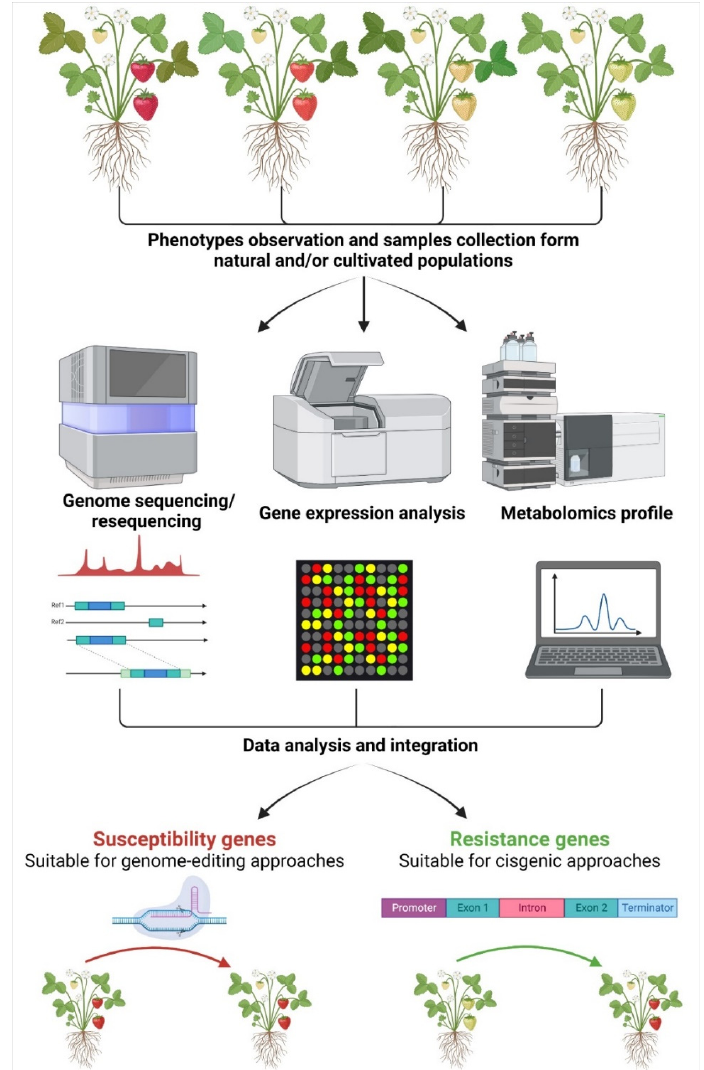
Figure 1. Overview of the multidisciplinary approaches to identify candidate gene(s) exploitable for genome editing or cisgenesis approaches. Starting from the natural occurring phenotypes, including both cultivated and wild genotypes, it is possible to identify genetic sequences involved in the determination of specific traits. More in detail, combining genomic analysis with gene expression and metabolomic data, it is possible to identify pathways and key genes controlling the trait(s) of interest. Once identified, if concerning negative regulator(s), such as stress-related susceptibility genes, it is possible to apply genome editing to obtain an improved genotype where the expression of such gene(s) will be knocked-out. On the contrary, the identification of positive regulator(s) can be exploited in cisgenesis approaches to obtain new genotypes expressing the resistance/tolerance- related gene(s). As a second step of complexity, the ability to transform and regenerate elite fruit crop genotypes represents the most dramatic bottleneck. In fact, the selection of the best starting tissue for the transformation event, similarly to the selection of the most suitable tissue for protoplasts isolation, is not easily achievable in all fruit crops (Figure 2).